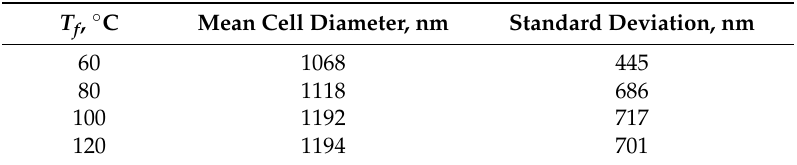
Table 3. The mean cell diameter and standard deviation of ABS/R-PET blend foams